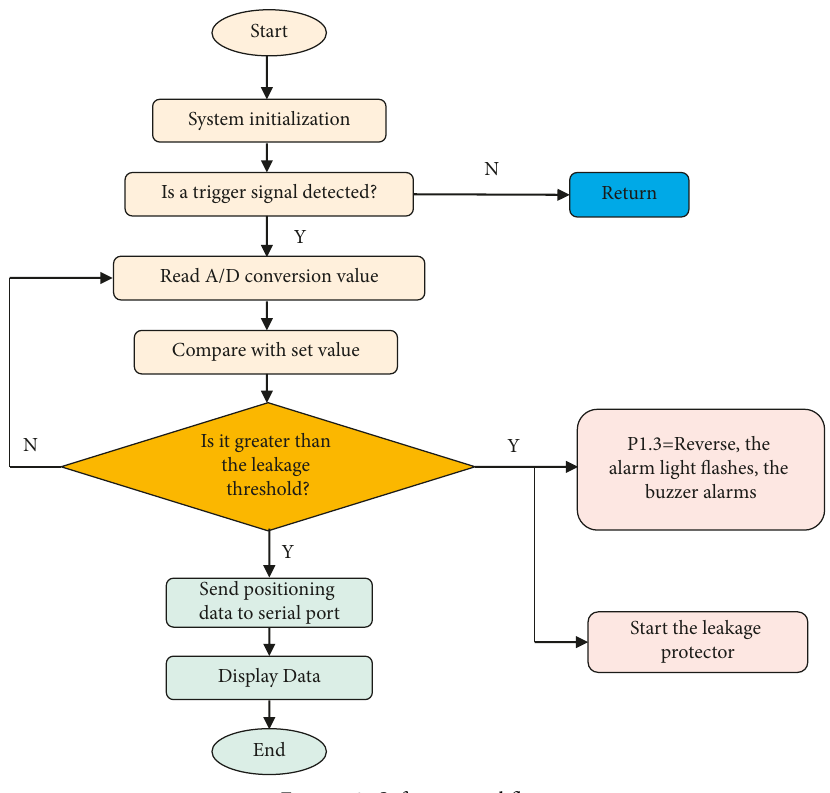
Figure 2: Software